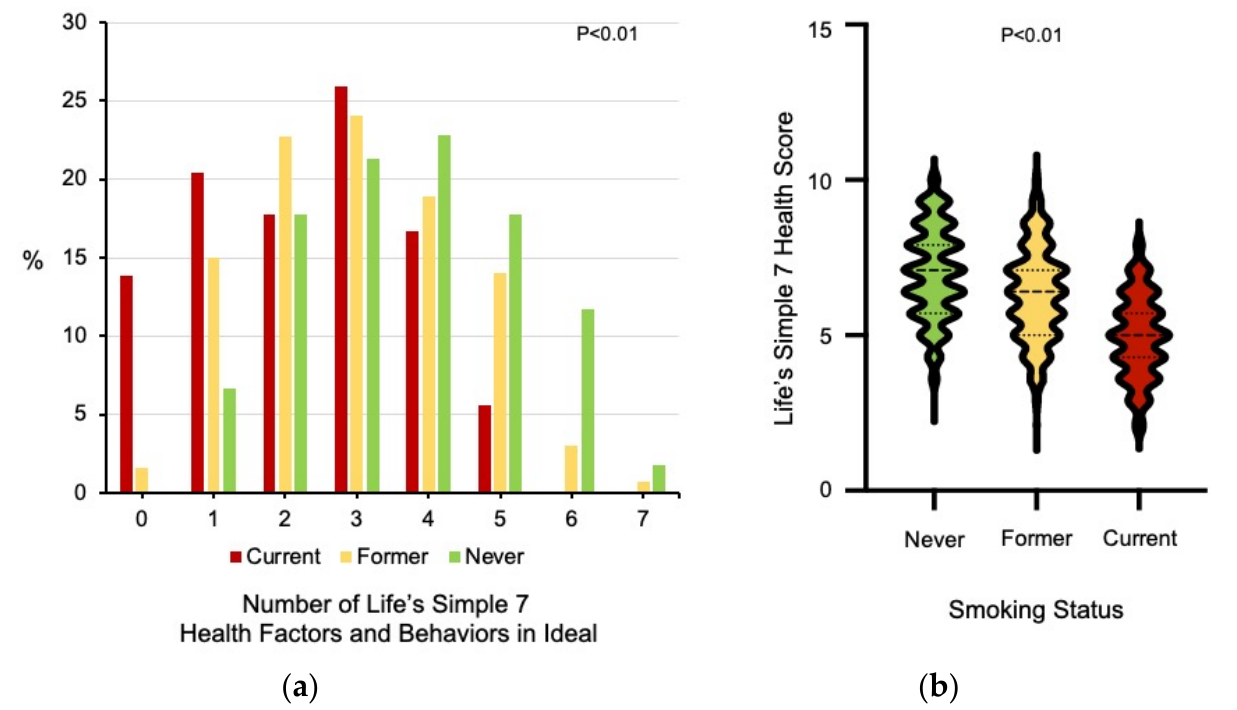
Figure 1. Life’s Simple 7 health factors and behaviors in the ideal range and ideal cardiovascular health. ( a ) The 7 health factors and health behaviors that are assessed by the Life’s Simple 7 survey instrument are scored as ideal, intermediate, or poor according to criteria defined by an expert panel [7,17]. The number of categories scored as ideal is presented for current ( n = 108), former ( n = 428), and never smokers ( n = 1025). Data was analyzed using the Kruskal–Wallis test. ( b ) The distribution of Life’s Simple 7 Health Scores for never, former, and current smokers is shown as violin plots with median and quartiles identified as dashed lines. Data was analyzed using the Kruskal–Wallis test.